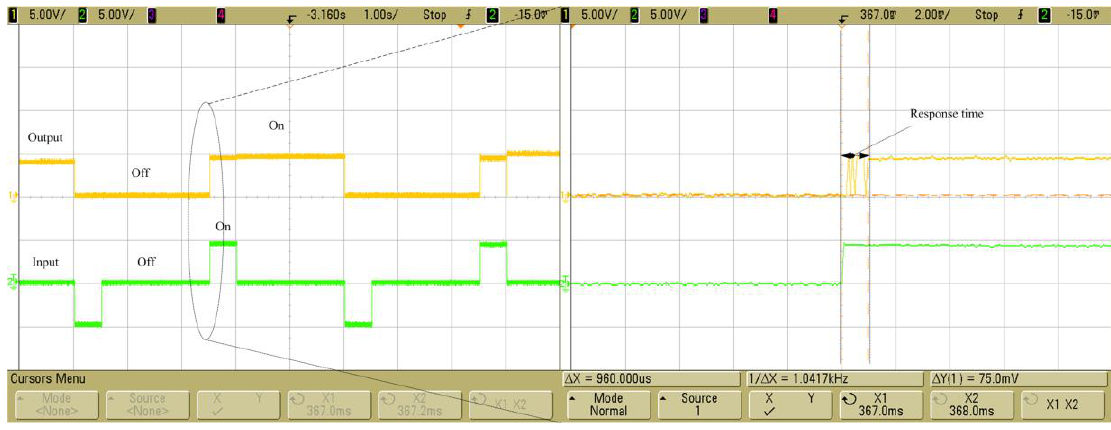
Figure 15. Bistable mechanism testing results and response time of the prototype.